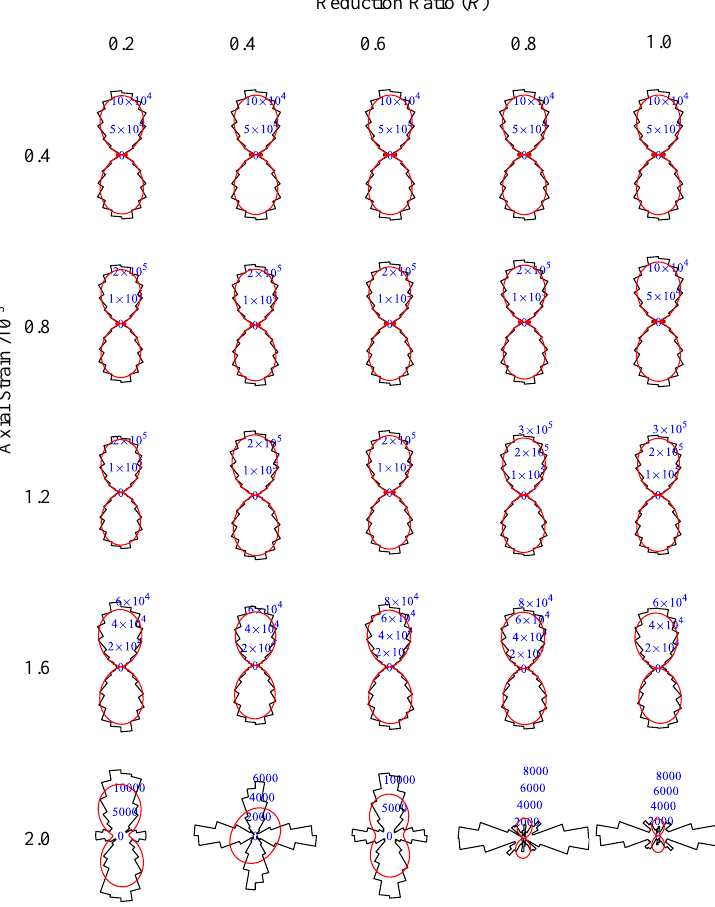
Figure 10. Summary of contact force – chains orientation.